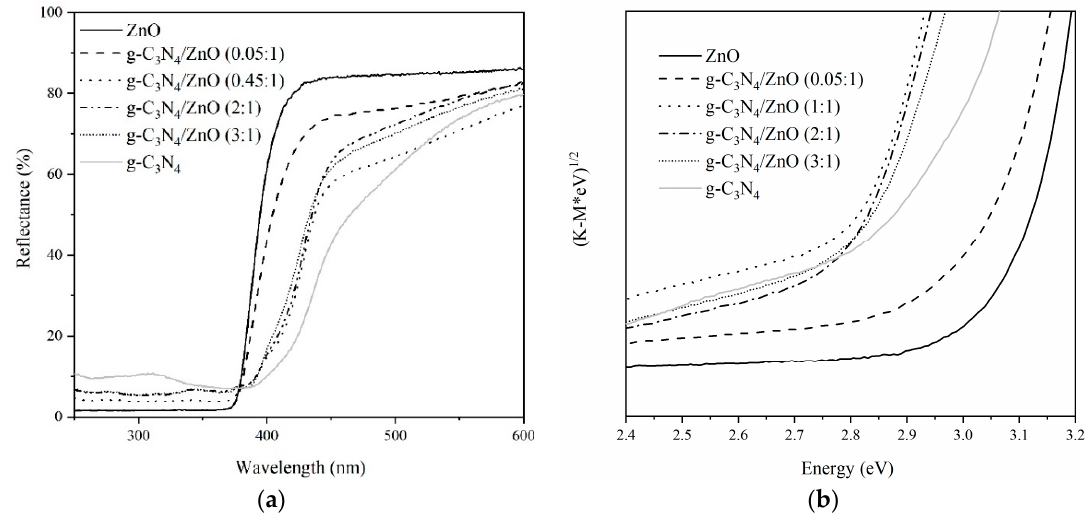
Figure 3. UV-vis diffuse reflectance spectra ( a ) and Tauc plots ( b ) of ZnO, g-C 3 N 4 , and g-C 3 N 4